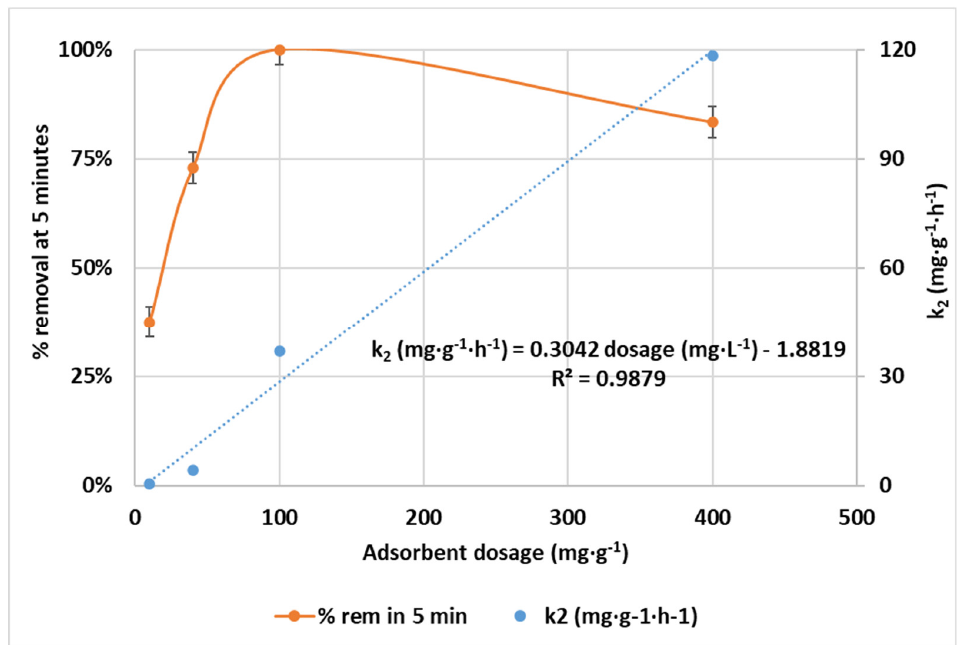
Figure 5. Evolution of removal of hexavalent chromium in 5 min of contact time (%) and PSO kinetic constants during adsorption batch experiments with CCNC at 0.1 mg·L −1 of initial chromium concentration, pH 3 and room temperature while varying CCNC dosage from 10 to 400 mg·L −1 .